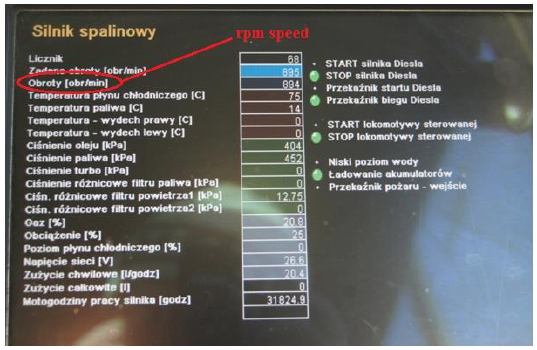
Fig. 3. General view of the onboard measurement system